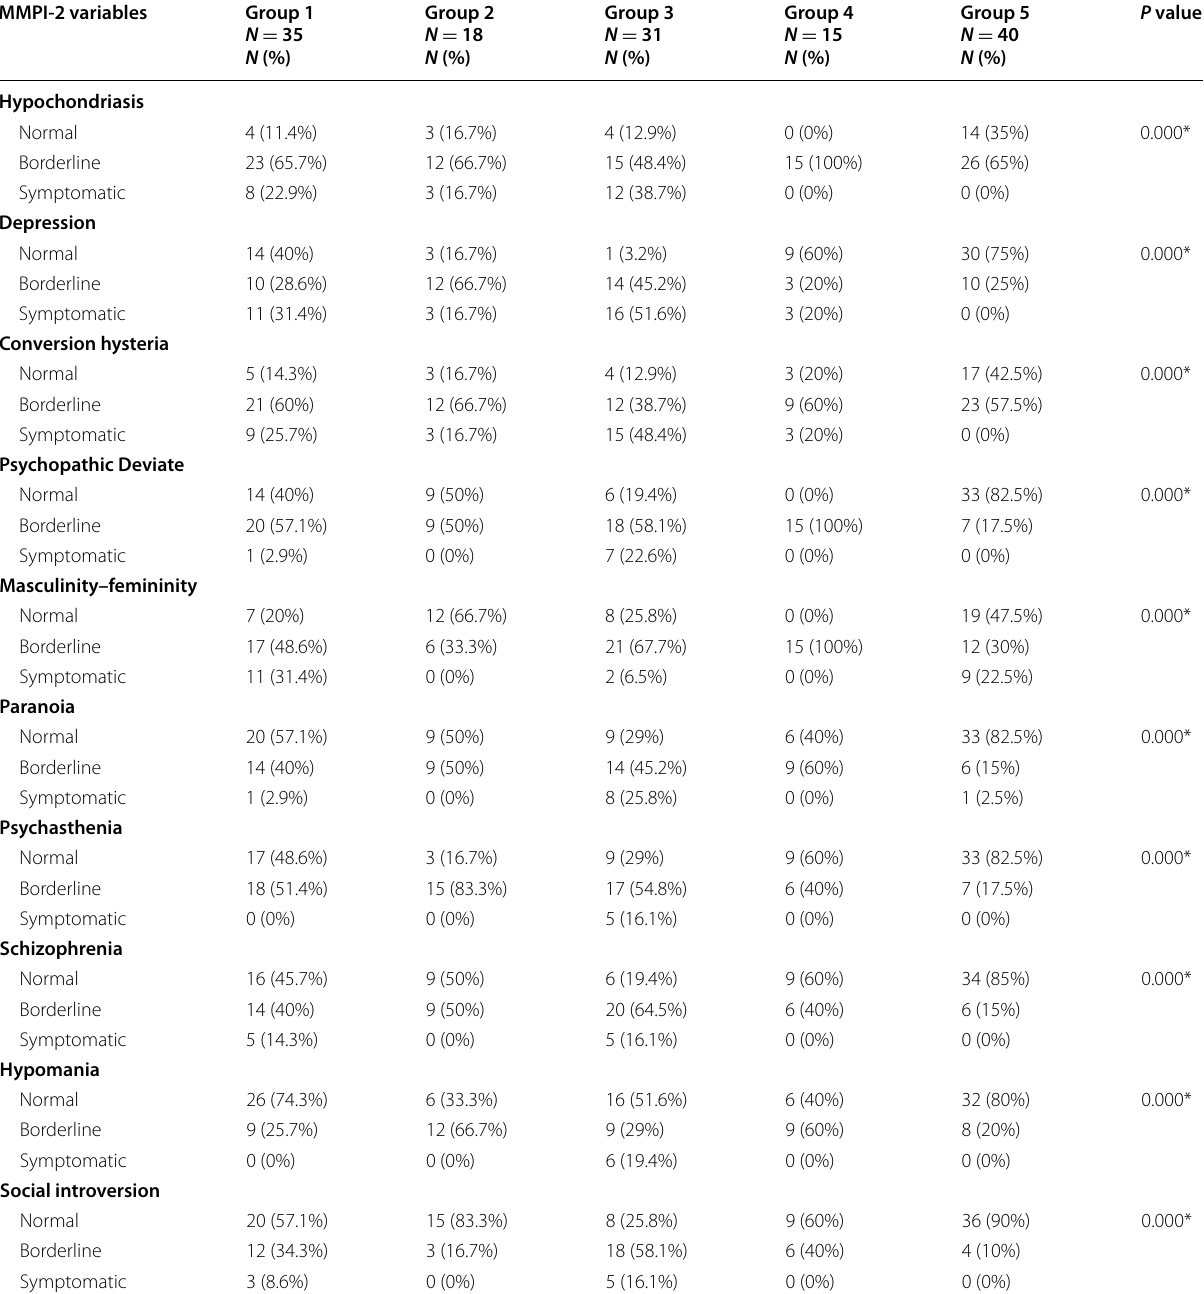
Table 5 The Minnesota Multiphasic Personality Inventory (MMPI-2) among the studied samples